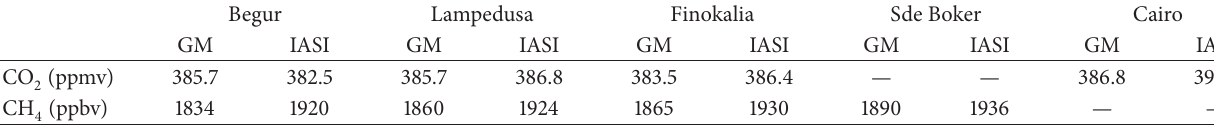
Table 2: Time averaged values of the ground measurements (GM) and retrieved (IASI) columnar tropospheric content of trace gases.